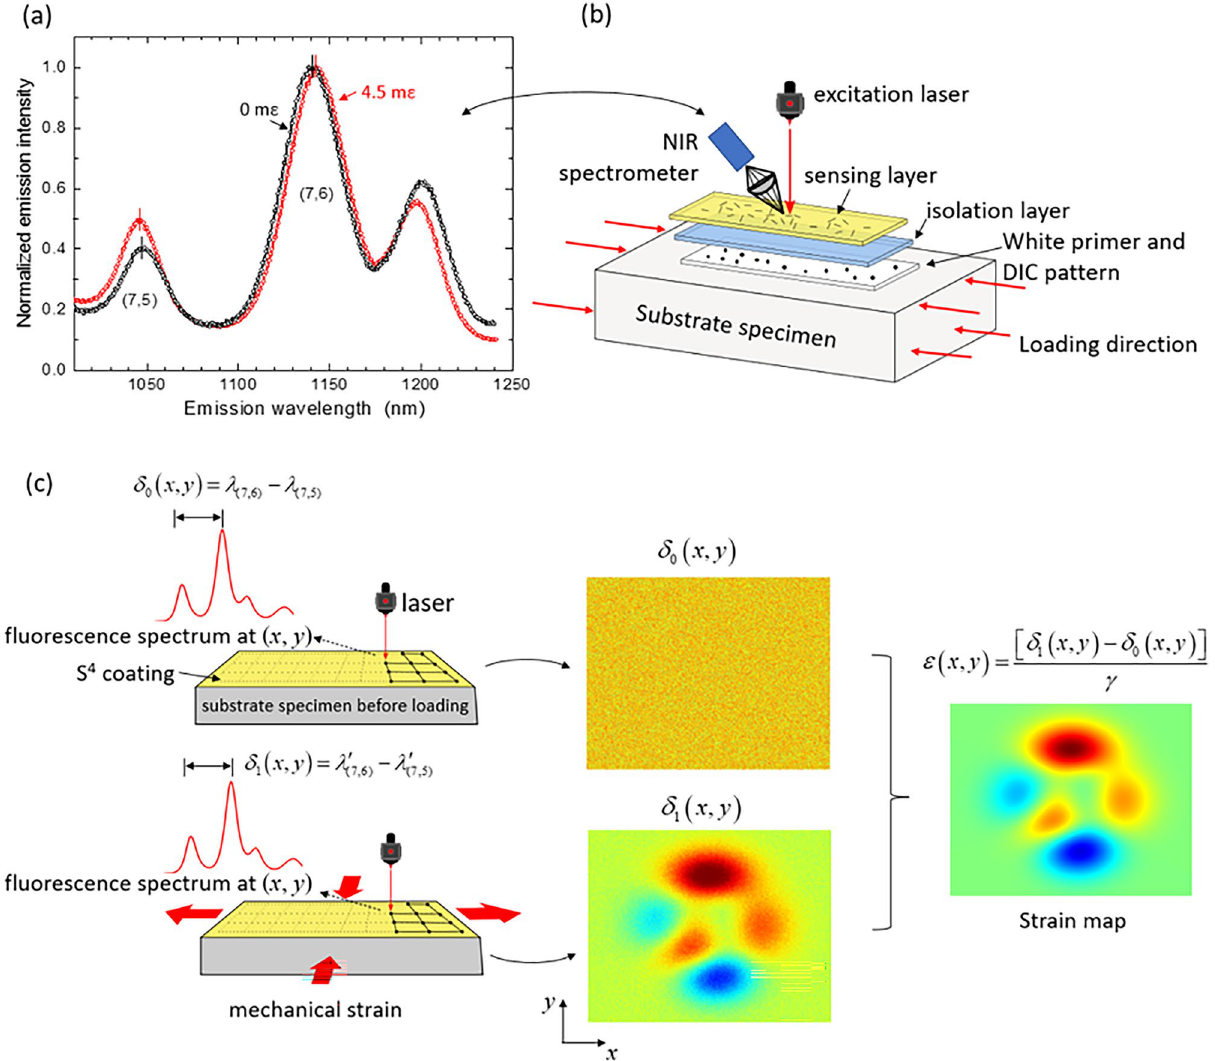
Figure 1. ( a ) Emission spectrum from an S 4 film on a specimen with substrate strain of 0 (black points) and 4.5 mε (red points) [adapted from reference 30 ]; ( b ) layer-structured S 4 film; ( c ) scheme for measuring 2D strain maps in the S 4 method. The specimen is raster-scanned before (left top) and after (left bottom) stress testing to find the spectral peak separation at each grid point. Those separations are then pointwise subtracted and divided by the spectral gauge factor to obtain the specimen’s strain map (7,6) and (7,5) peak wavelengths is proportional to the specimen strain, with a “spectral gauge factor” defined by the slope: